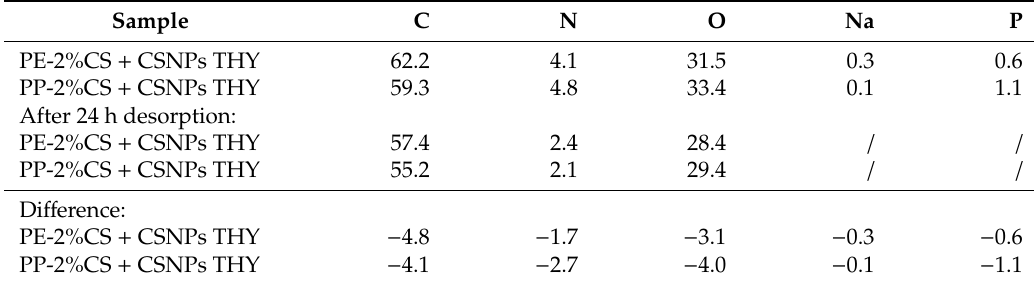
Table 6. Surface chemical composition of PE / PP-2%CS + CSNPs THY-coated foils before and after desorption experiment (at.%).